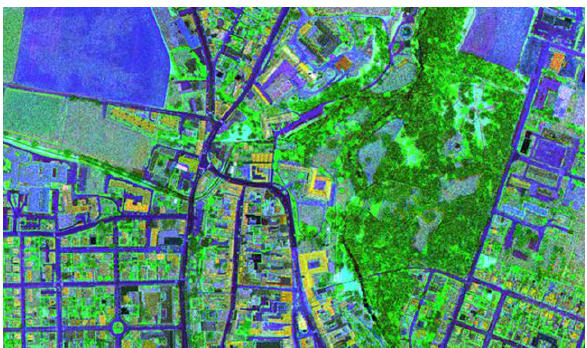
Figure 8. Detail view of figure 7 (rotated to the